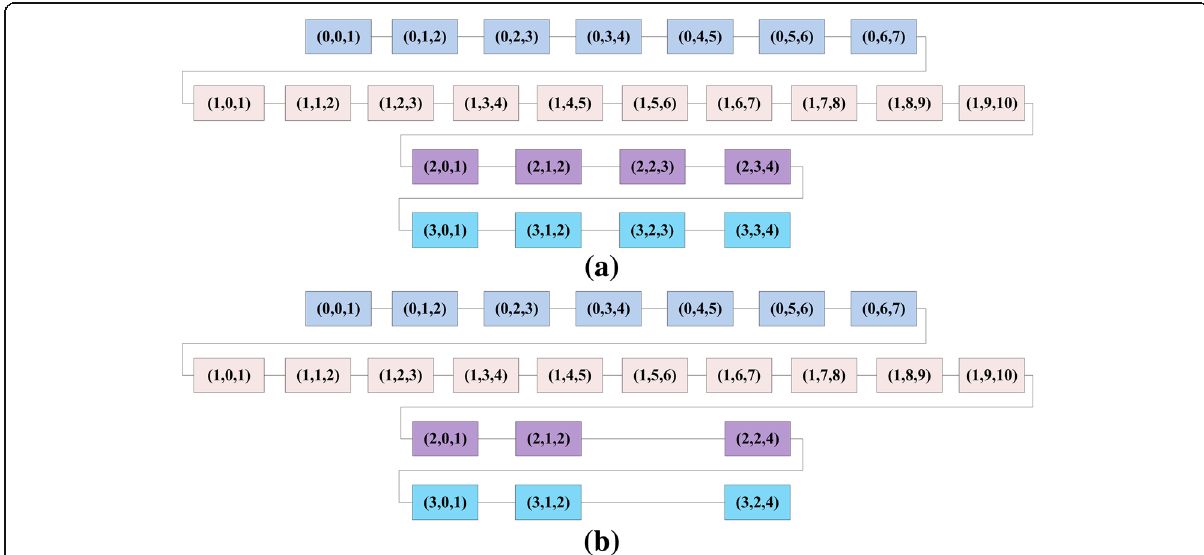
Fig. 5 The sequence of the cells. a The sequence of the original cells. b Optimized partition order. This figure well represents the one-dimensional order of the network